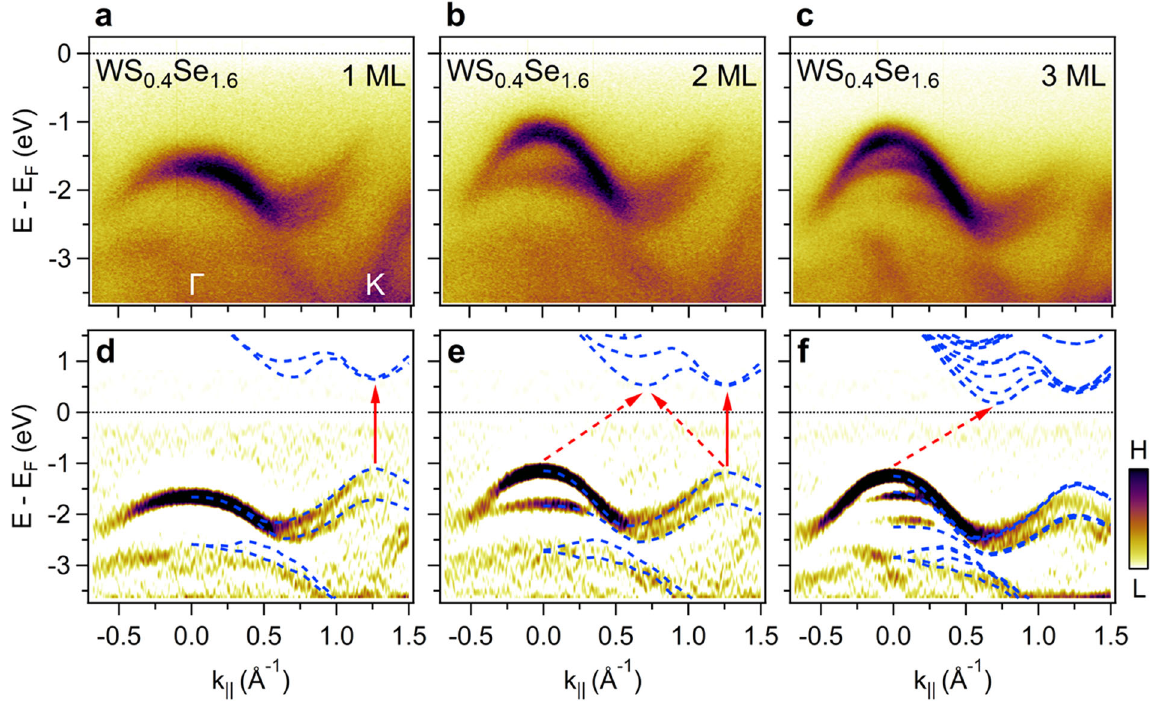
Fig. 4 Electronic band structure for mono and few layers of WS 2(1 − x ) Se 2 x ( x = 0.8). Nano-ARPES images acquired on: a 1 ML, b 2 ML, and c 3 ML WS 2(1 − x ) Se 2 x ( x = 0.8) along the Γ − K direction and taken at a photon energy of 100 eV. d – f Second derivative spectra of the ( a – c ) panels on which the calculated band structure obtained by DFT (blue dashed lines) is superimposed. Table 1. Spin – orbit splitting at K and VBM at Γ and K obtained from the experimental ARPES data of Fig. 4a – c for mono-, bi- and tri-layer WS 2(1 − x ) Se 2 x ( x =